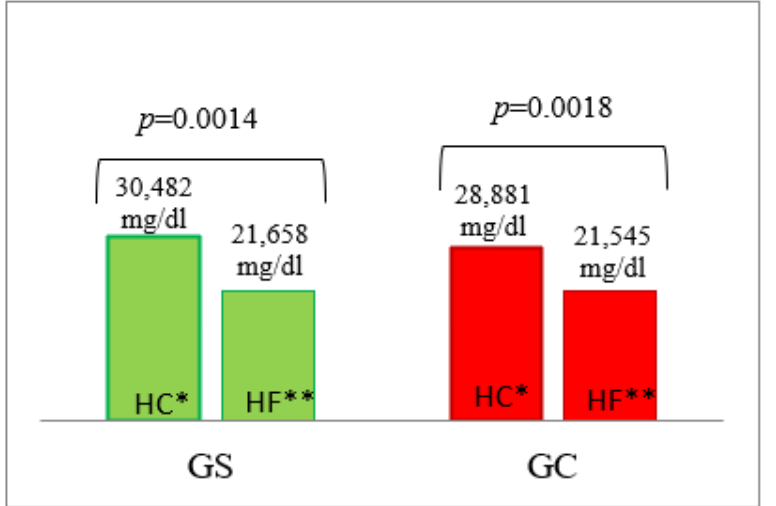
Figure 1. The AUC of glucose concentrations in the G S and G C groups after HC and HF meals. The results are presented as the mean values. * difference between the G S (obese/overweight) and G C (normal body weight) groups after HC meal (high-carbohydrate meal ( p = 0.5726)); ** difference between the G S and G C groups after HF meal (high-fat meal ( p = 0.7004)). There were no statistically significantly correlations between postprandial serum glucose concentrations, following either the HF or the HC meal, and